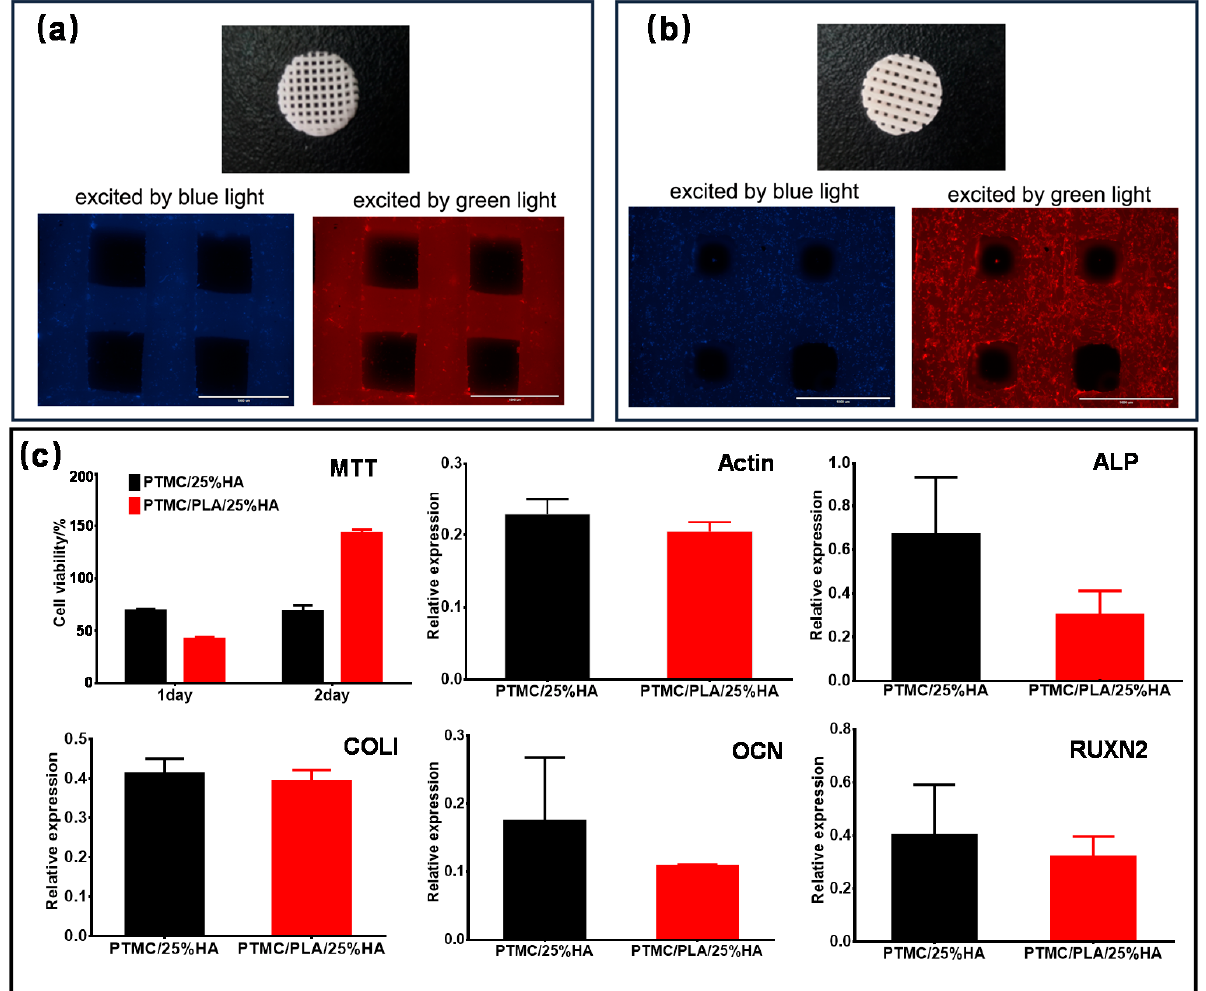
Figure 8. Phalloidin staining images of cells after 7 days culturing on the scaffolds of ( a ) PTMC/25%HA scaffolds, and ( b ) PTMC/PLA/25%HA scaffolds. ( c ) MTT assay and effects of the scaffolds on mRNA expression of the Actin, Runx2, ALP, and Col I genes on day 7.